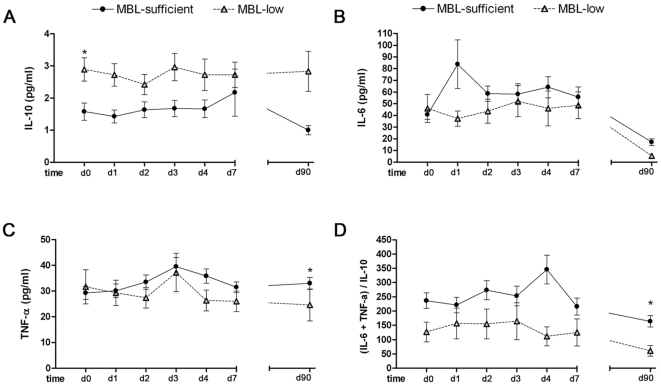
Cytokine levels (pg/ml) in blood in MBL-low genotypes and MBL-sufficient genotypes.A) Interleukin-10; B) Interleukin-6; C) TNF-α; D) Balance between T helper (h) 1 cytokines and Th2 cytokines calculated as (TNF-α + IL-6)/IL-10. Measurements were performed in serum samples at day 0 (d0) (n = 129; MBL-low = 23, MBL-sufficient = 106); day1 (d1) (n = 121; MBL-low = 22, MBL-sufficient = 99); day 2 (d2) (n = 122; MBL-low = 22, MBL-sufficient = 100); day 3 (d3) (n = 116; MBL-low = 19, MBL-sufficient = 97); day 4 (d4) (n = 111; MBL-low = 16, MBL-sufficient = 95), day 7 (d7) (n = 101; MBL-low = 16, MBL-sufficient = 85), and day 90 (d90) (n = 92; MBL-low = 15, MBL-sufficient = 77). Values are the mean ± SD. *p<0.05, **p<0.01.